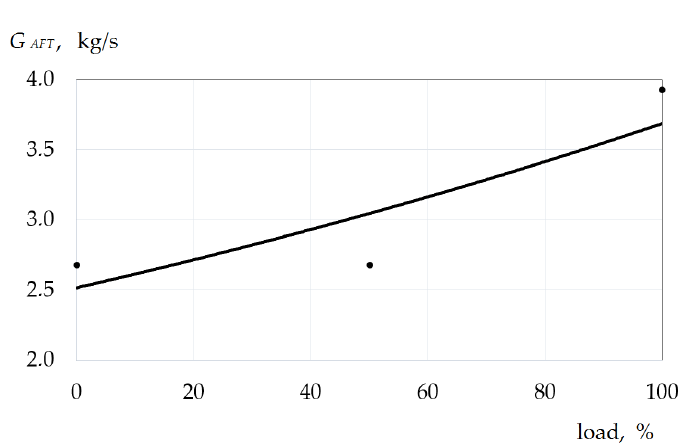
Figure 14. Dependence of afterburning air consumption for all combustion chambers on the load value.